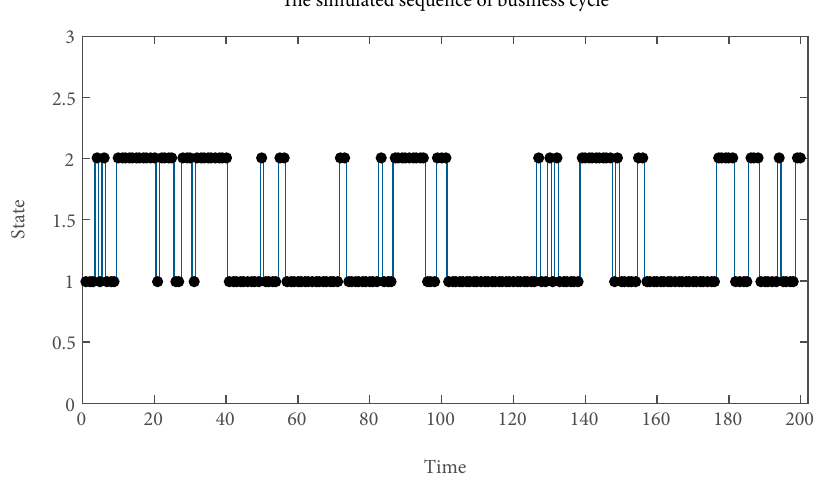
Figure 5: Simulated sequence of business